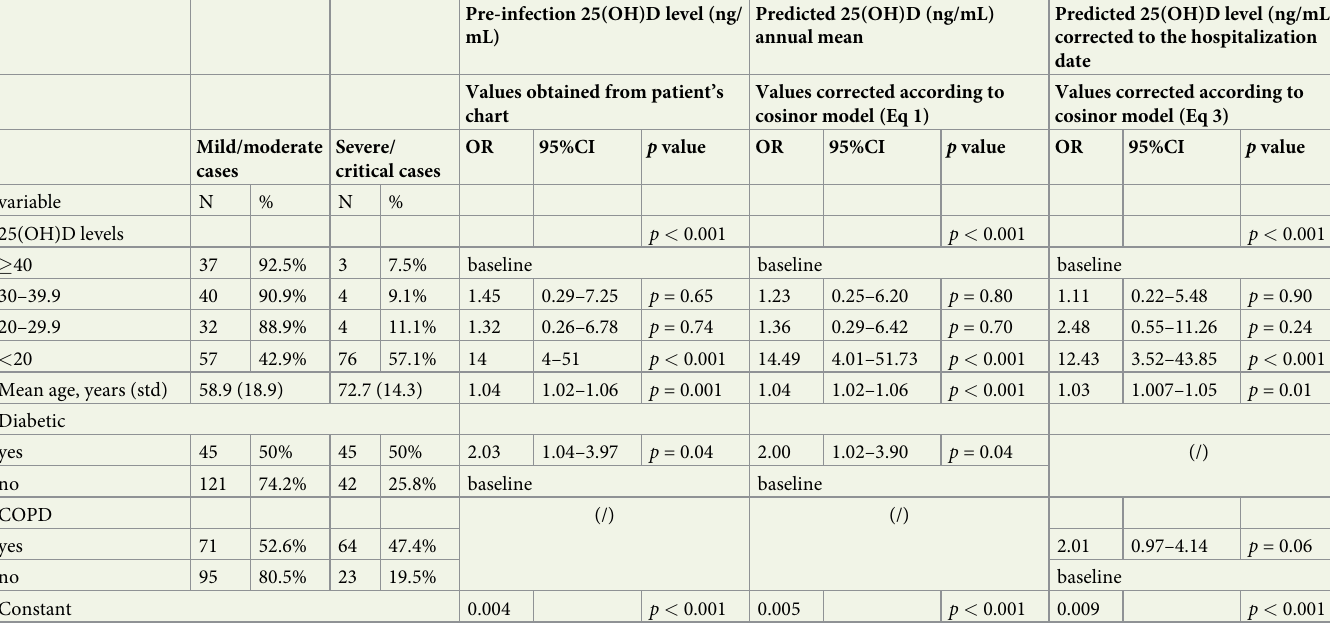
Table 4. Multivariable logistic regression analysis of possible predictors of severe or critical COVID-19 disease among hospitalized patients with a pre-infection measurement of 25(OH)D level. The multivariable analyses before and after cosinor correction models for the annual mean as well as each patient’s date of hospitaliza- tion are shown. This is the final step in the logistic regression (backward